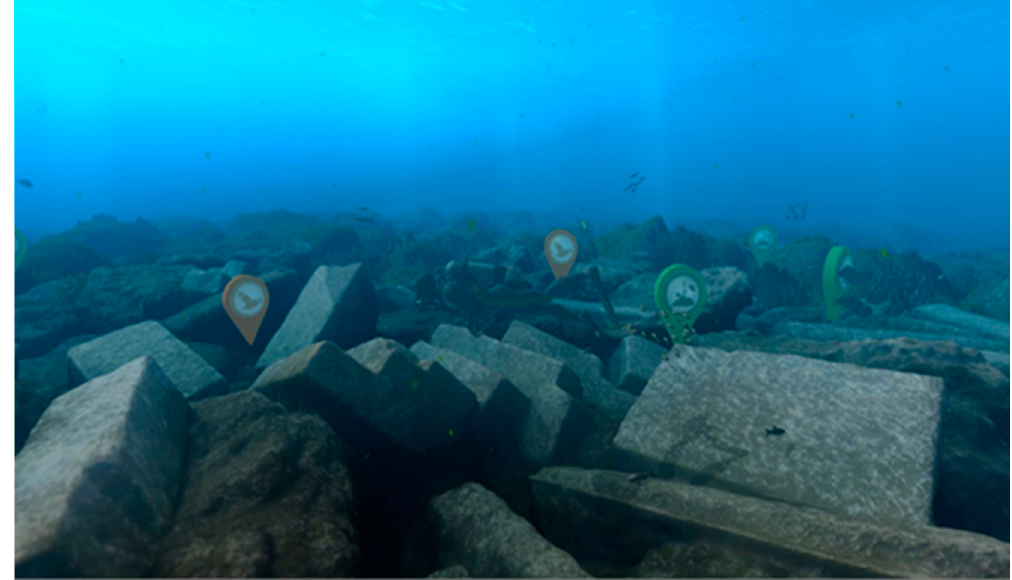
Figure 1. Virtual reconstruction of an underwater archaeological site with 3D points of interest (POIs), flora and fauna.